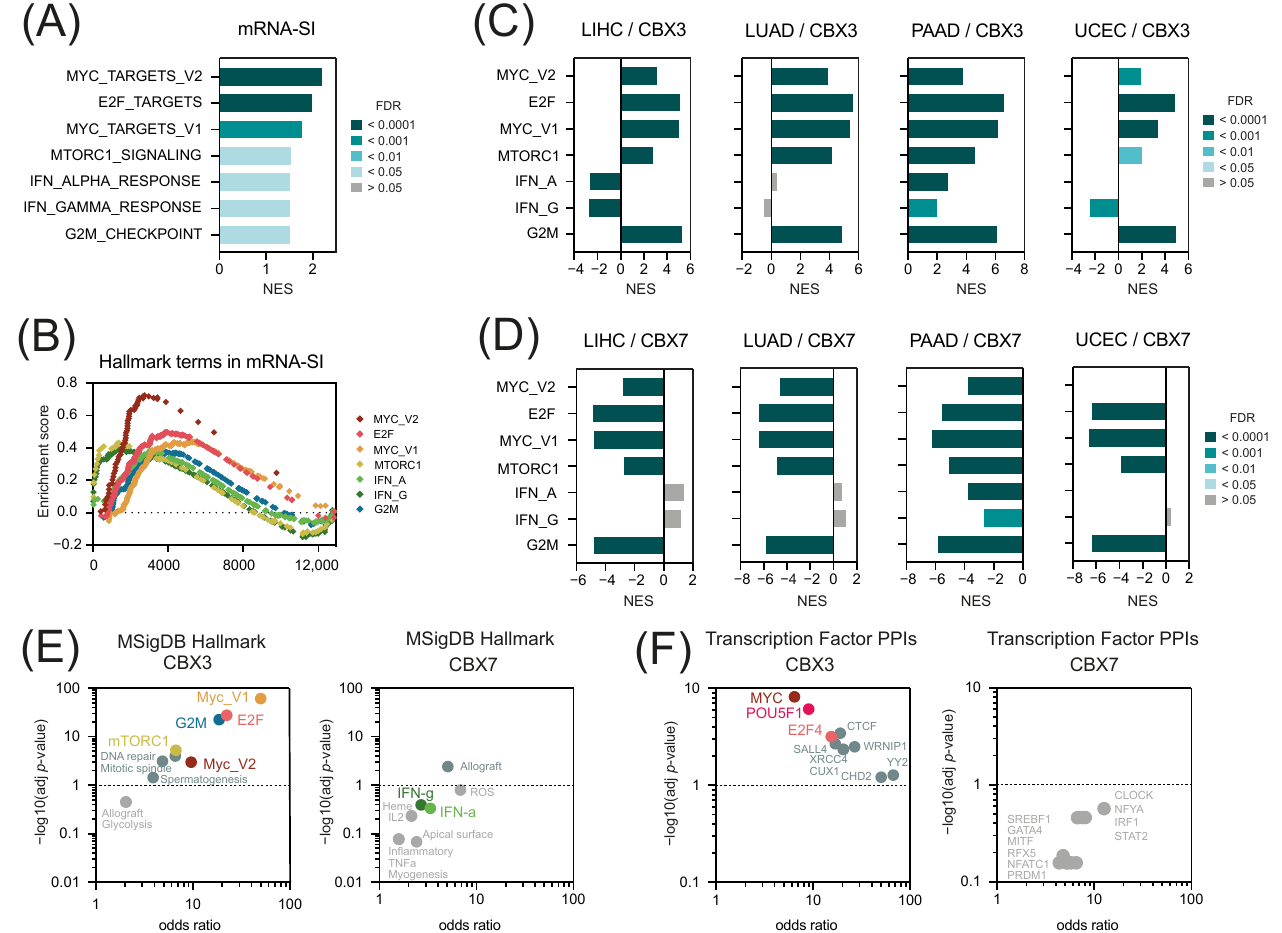
Figure 7. The transcriptome profiles associated with the expression of CBX3 are enriched with c-Myc and E2F transcription factor targets that significantly mirror the enrichment of mRNA-SI gene signature with the “Hallmarks of cancer” terms. ( A , B ) The enrichment of mRNA-SI gene signature with the „Hallmarks of cancer” terms determined using the GSEA analysis with the MSigDB Hallmark (v7.4) collection as a reference. Bars—Normalized Enrichment Score (NES). Bars are color-coded according to the statistical significance (FDR) as shown in the legend. ( C , D ) The CBX3-associated transcriptome profiles are enriched ( C ) while the CBX7-associated transcriptome profiles are depleted ( D ) with the “Hallmark of cancer” terms specific for cancer stem cell-like tumors. Bars—Normalized Enrichment Score (NES). Bars are color-coded according to the statistical significance (FDR) as shown in the legend. ( E ) The Enrichr tool [34] confirmed significant enrichment of CBX3-related gene expression profile